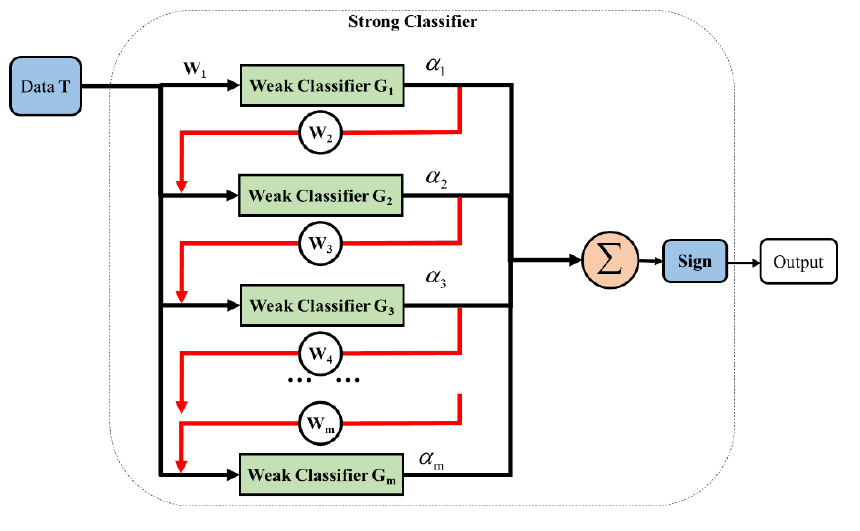
Figure 5. Flow chart of AdaBoost algorithm.